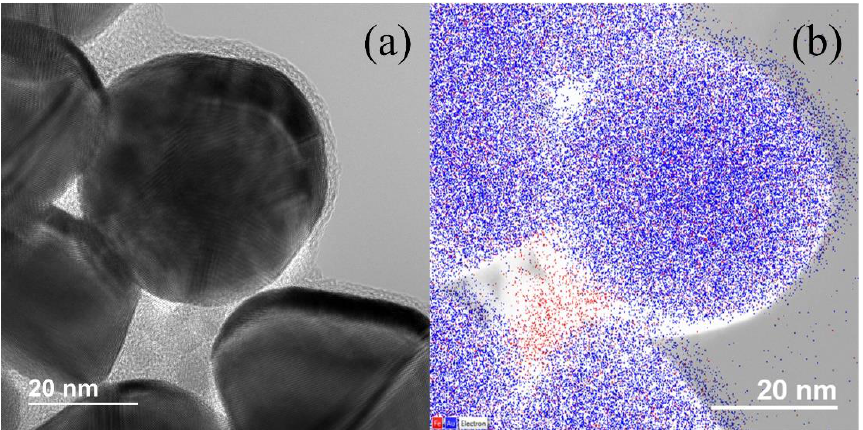
Figure 3. ( a ) HRTEM micrograph of MAuNPs (larger darker particles) and uncoated MNPs (smaller lighter particles). Gold and iron oxide lattice fringes are apparent. ( b ) EDS element map performed on a similar region of the same sample depicting Fe (red) and Au (blue).